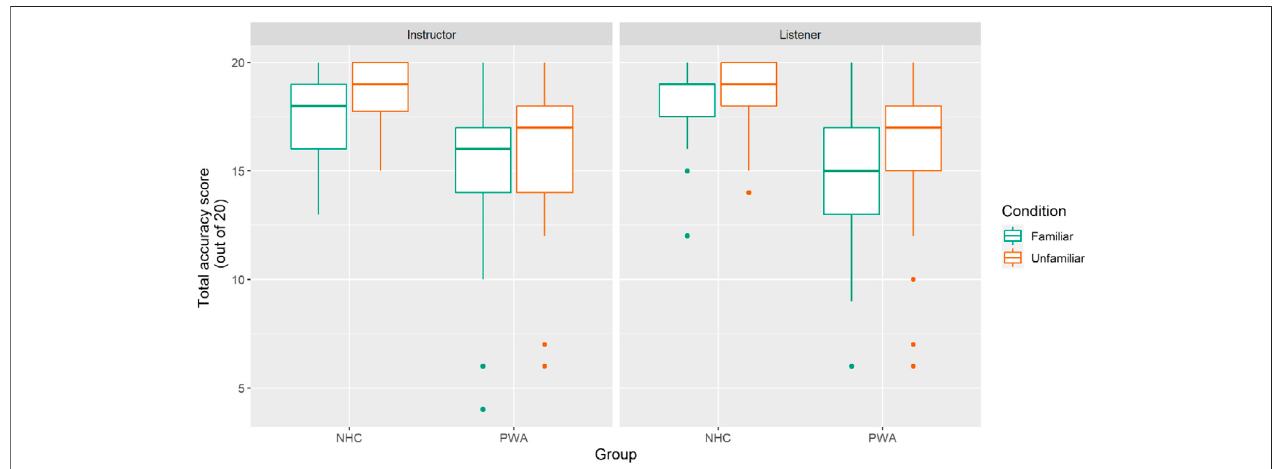
FIGURE 5 | Boxplots showing total accuracy score (out of 20) by condition and group, for each role